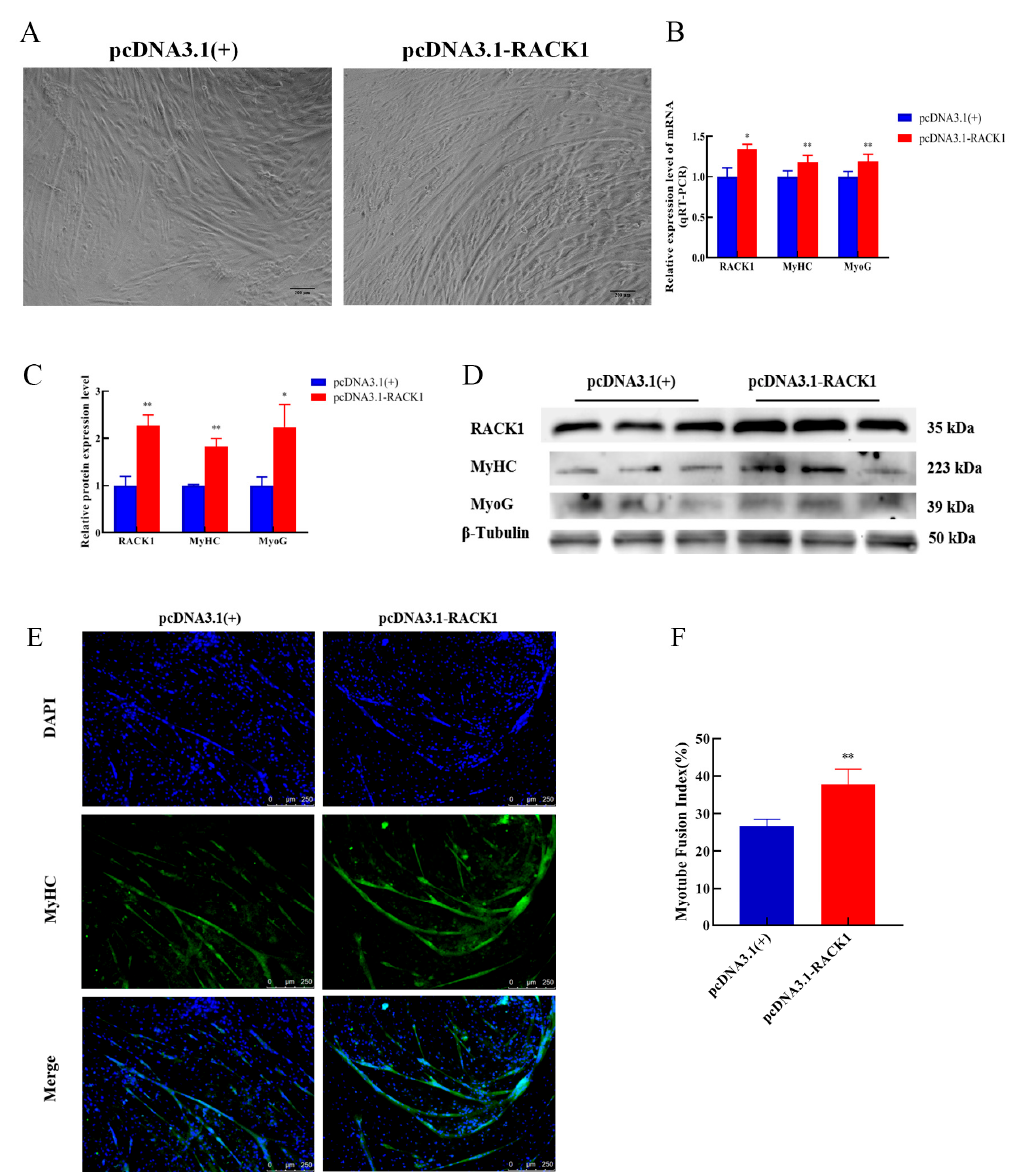
Figure 6. Effects of RACK1 overexpression on myogenic differentiation of bovine skeletal muscle. ( A ) Light micrographs (100 × ) of cells before and after overexpression of RACK1. ( B ) qRT-PCR de- tection of overexpression of RACK1 on muscle differentiation markers (MyHC and MyOG). ( C , D )